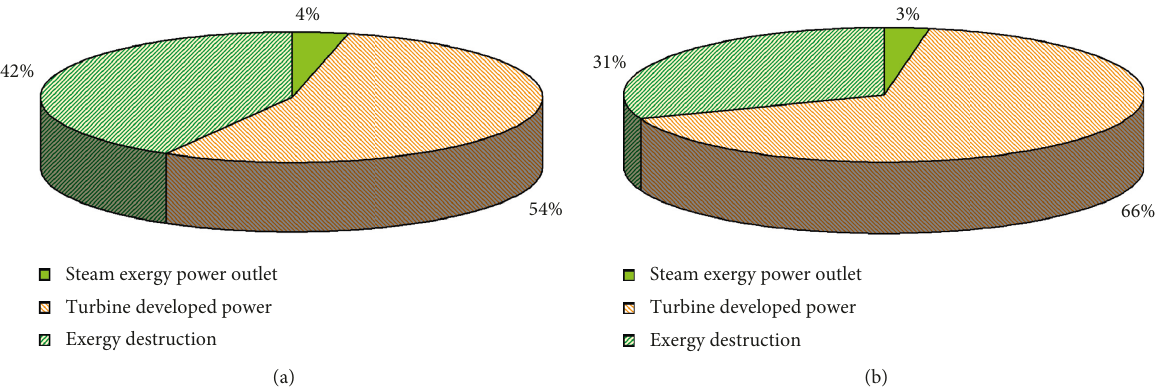
Figure 5: Distribution of steam turbine exergy power inlet for operating point 3 in exploitation (a) and at the maximum exergy efficiency